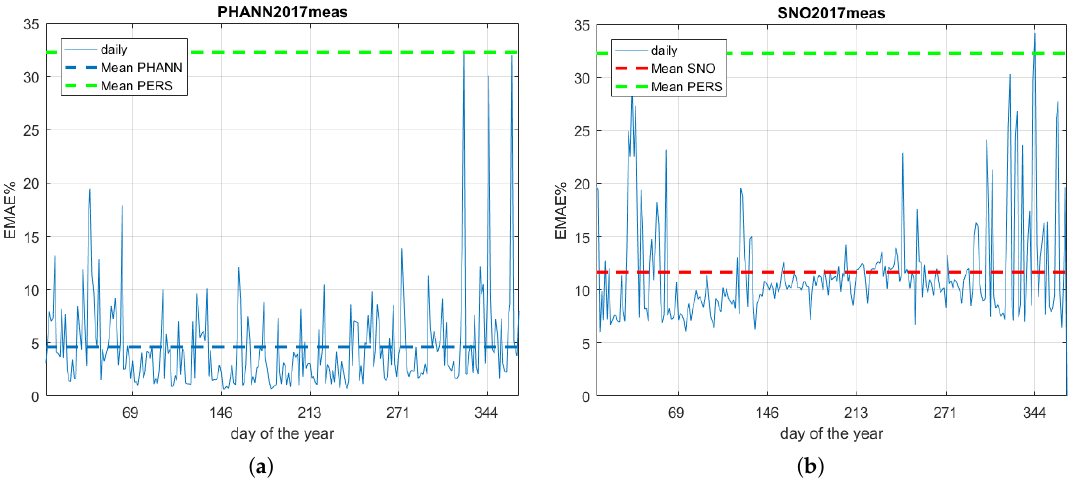
Figure 8. Daily EMAE% for 2017 using measured weather data: ( a ) PHANN; and ( b ) SNO based model.